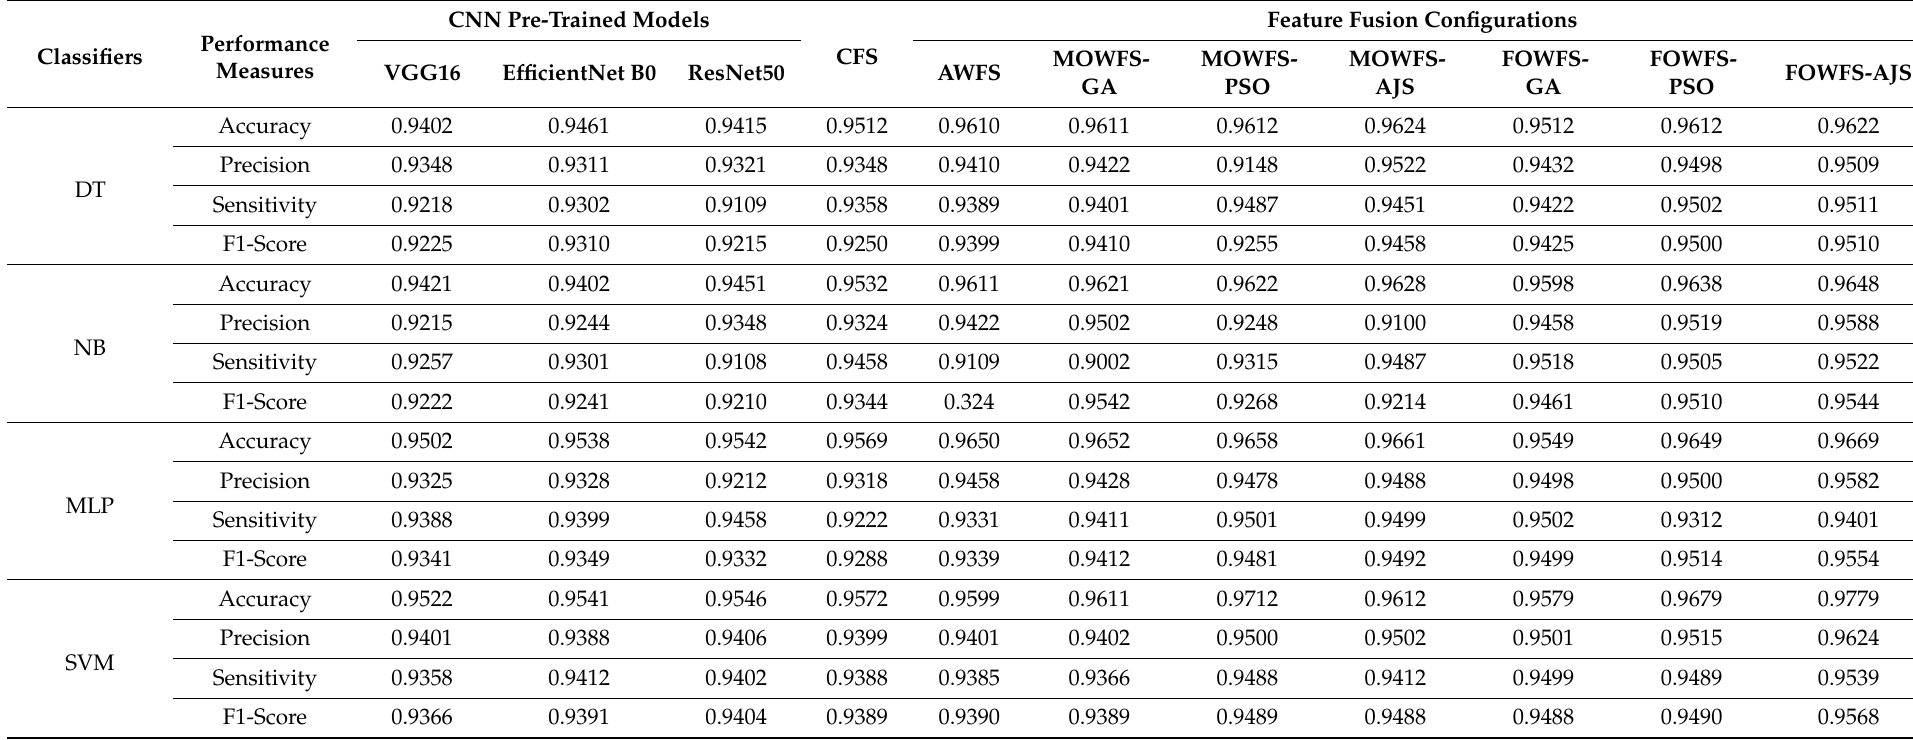
Table 9. Recognition performance with respect to CNN’s pre-trained models, CFS, and feature fusion configurations for BCN 20000